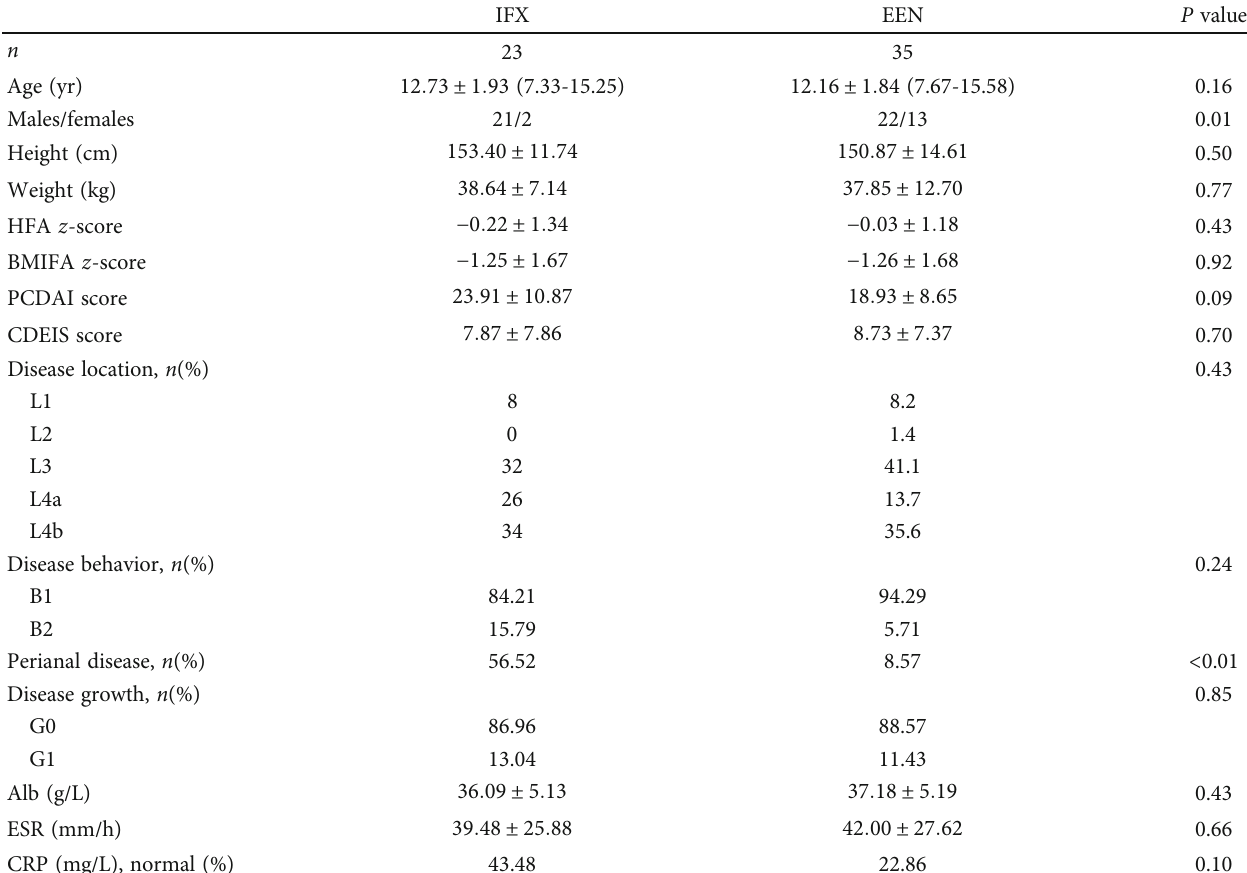
Table 1: Demographic and clinical data at baseline of per treatment